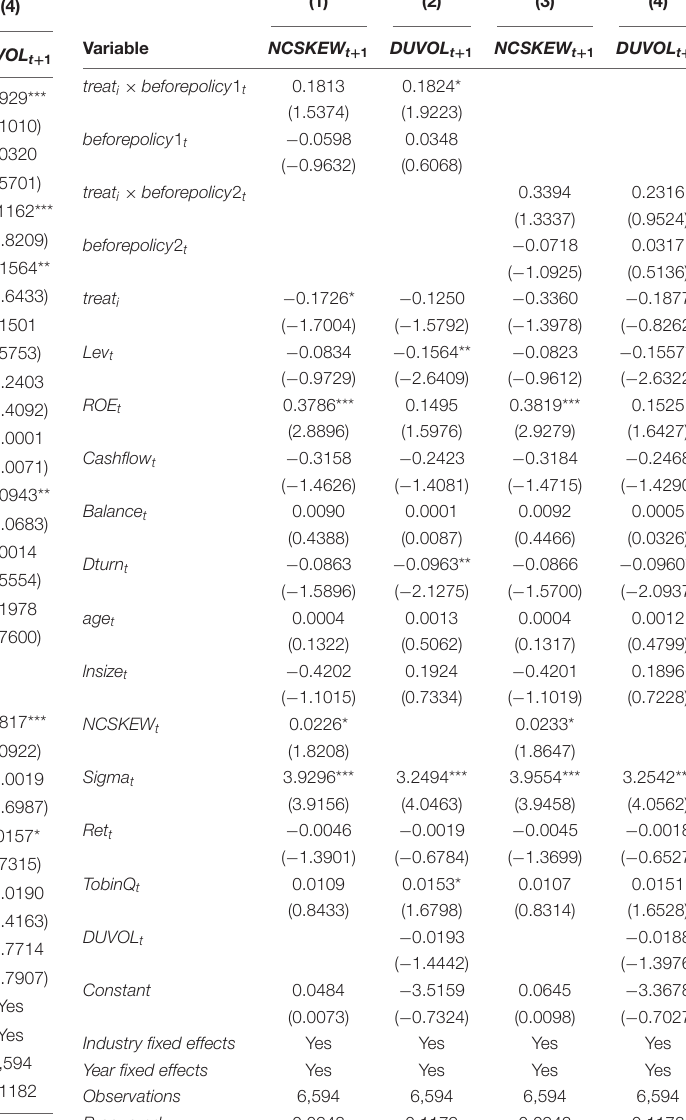
TABLE 2 | Baseline regression results.